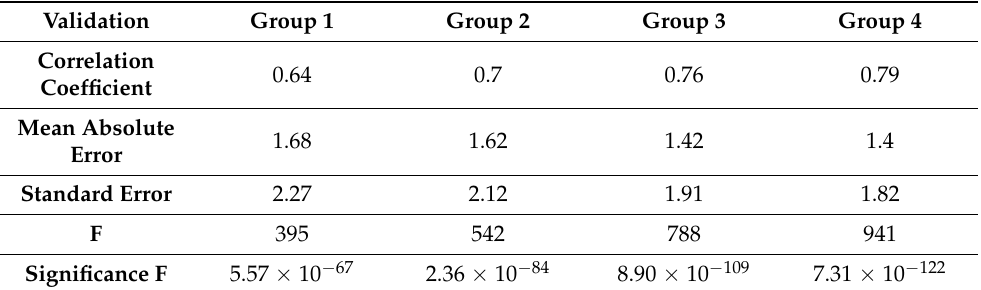
Table 2. R, mean absolute error (PU), standard error, F, and Significance F for actual versus predicted porosity logs for only the wells not used in the training